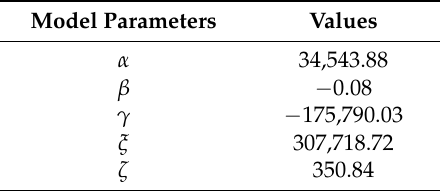
Table 1. Fitting parameters of the